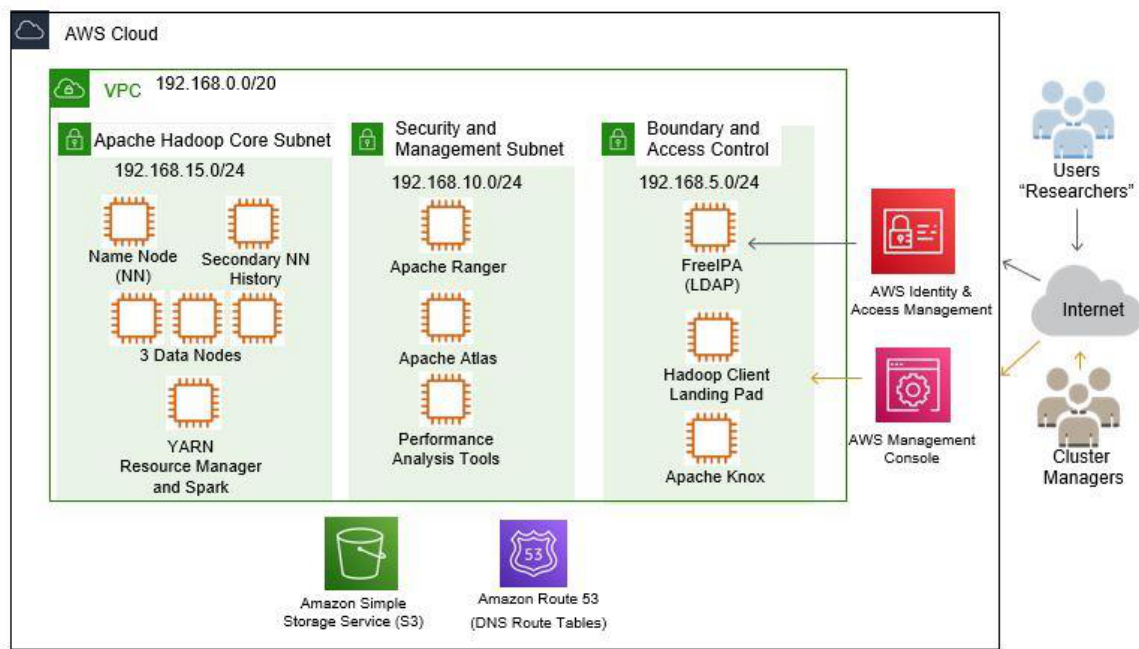
Figure 9. AWS EC2 instances for the security analysis of Apache Hadoop.